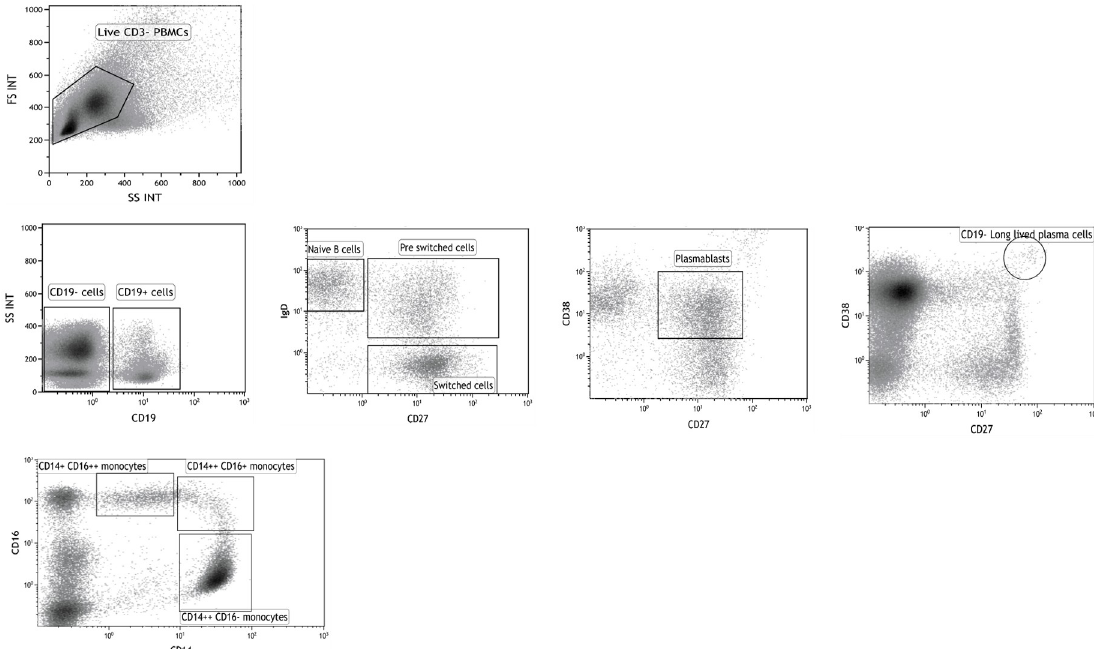
Fig 1. Gating strategies. Gating strategies for analysis of CD3- CD19+ CD27- IgD+ na ï ve B cells, CD3- CD19+ CD27+ IgD+ pre-switched B cells, CD3- CD19+ CD27+ IgD- switched B cells, CD3- CD19- CD27 hi CD38 hi long-lived plasma cells and monocyte subsets.